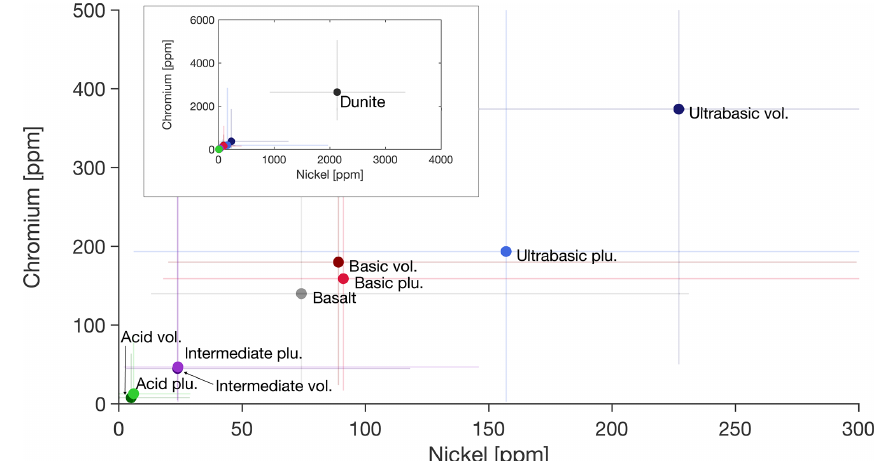
Figure 4. Contents of Ni and Cr in igneous rocks, classified by SiO 2 content (see Fig. 2). Circles indicate median values; whiskers are the 10th and 90th percentiles. Extreme values of percentiles were cut off for better visibility of data. The inset shows a visualization of dunite as it features extremely high values. For detailed statistics, see Sect.